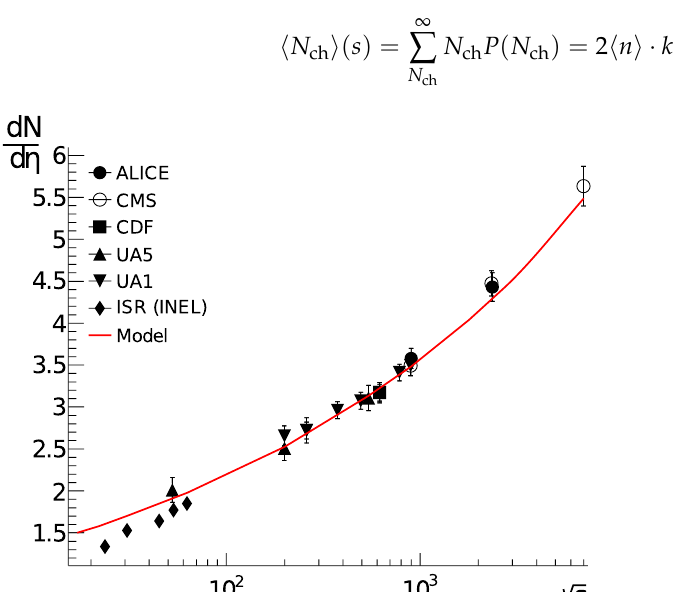
Figure 2. Pseudorapidity density of multiplicity as a function on energy. Experimental data on charged particle pseudorapidity density at midrapidity vs. pp or p ¯ p collision energy (data are borrowed from [88]) and the modified multipomeron exchange model—solid line [14].